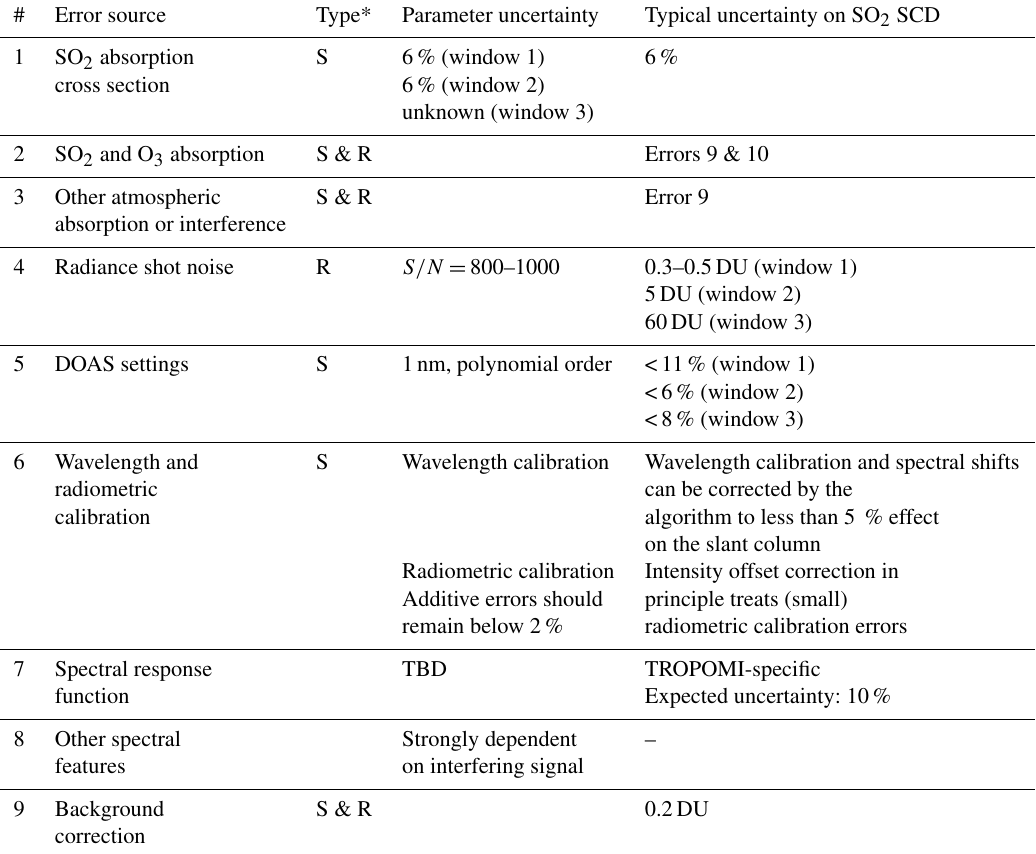
Table 5. Systematic and random error components contributing to the total uncertainty on the SO 2 slant column. # Error source